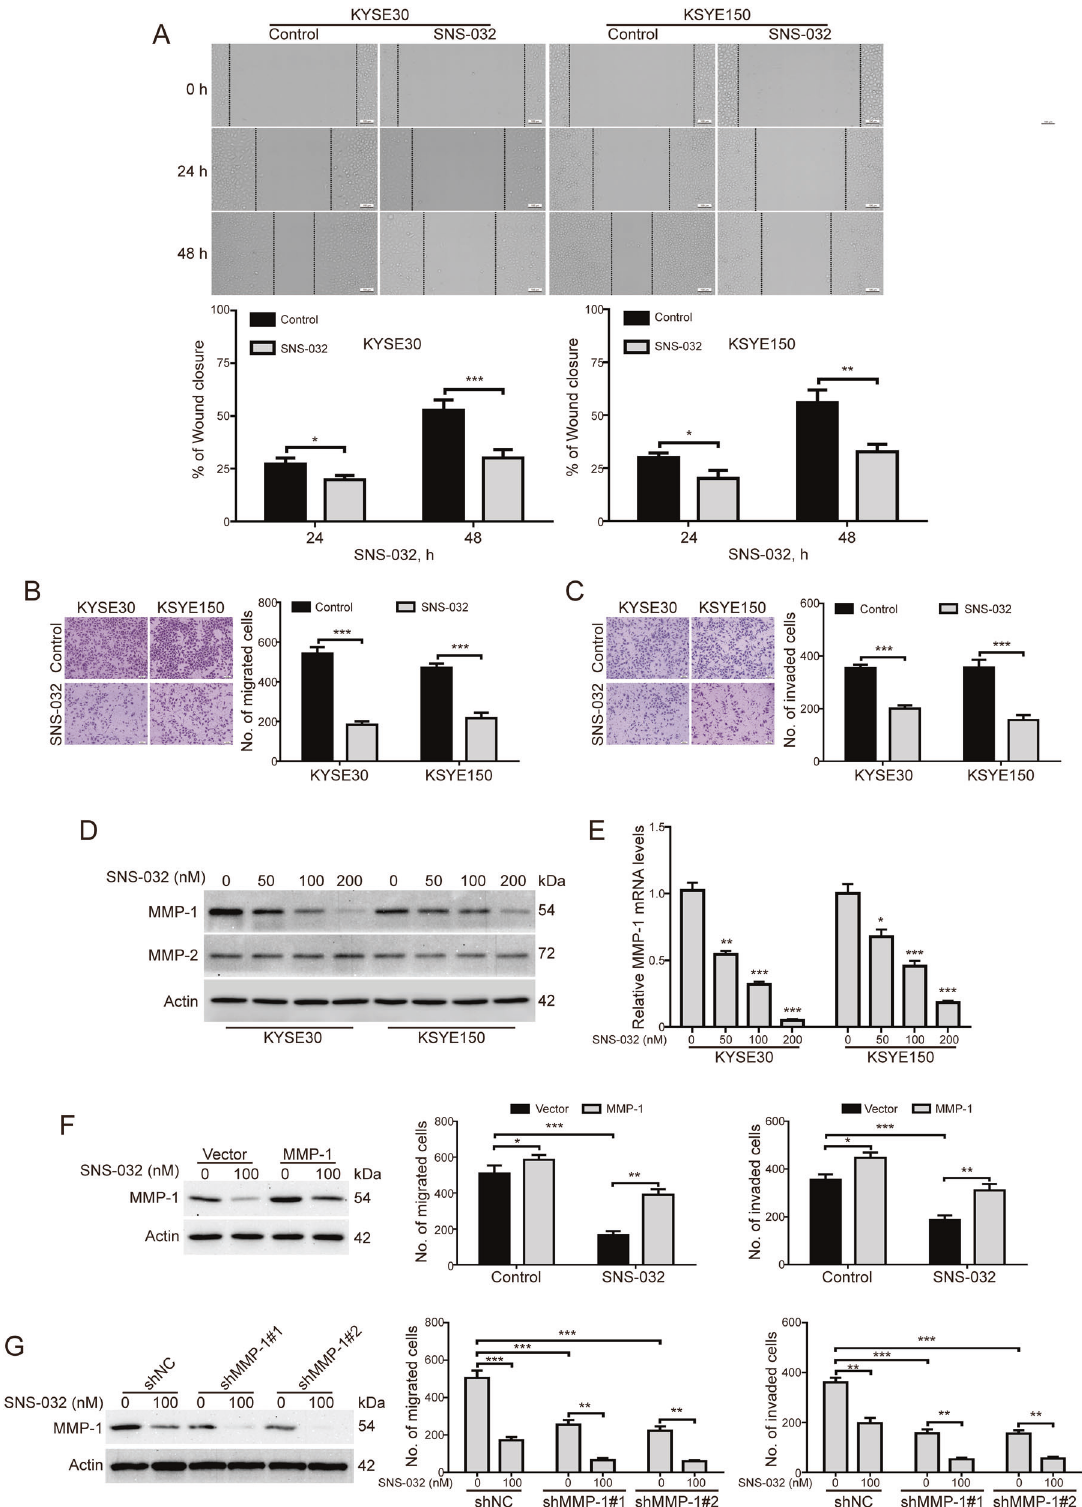
Fig. 4 SNS-032 attenuated migration and invasion of ESCC cells. A Wound healing assay was performed to examine the migration of ESCC cells (KYSE30 and KYSE150) incubated with 100nM SNS-032. Scale bar: 100 μ m. * P < 0.05, ** P <0.01, *** P <0.001, by Student ’ s t test. B , C SNS-032 suppressed the migration ( B ) and invasion ( C ) of ESCC cells detected by transwell assays. Left: Representative images; Right: Quantitative analysis of fi ve independent experiments. Scale bar: 100 μ m. *** P < 0.001, by Student ’ s t test. D Western blot analysis of MMP-1 and MMP-2 in KYSE30 and KYSE150 cells treated with increasing concentrations of SNS-032 for 48h. E SNS-032 dose-dependently decreased mRNA levels of MMP-1 in ESCC cells. * P < 0.05; ** P <0.01; *** P <0.001, one-way ANOVA, post hoc intergroup comparisons, Tukey ’ s test. F Enforced overexpression of MMP-1 rescued the inhibition of migration and invasion by SNS-032 in KYSE30 cells. * P <0.05; ** P < 0.01; *** P < 0.001, one-way ANOVA, post hoc intergroup comparisons, Tukey ’ s test. G Silencing MMP-1 by lentiviral shRNA signi fi cantly enhanced the inhibitory effects of SNS-032 on the migration and invasion of KYSE30 cells. ** P <0.01; *** P < 0.001, one-way ANOVA, post hoc intergroup comparisons, Tukey ’ s